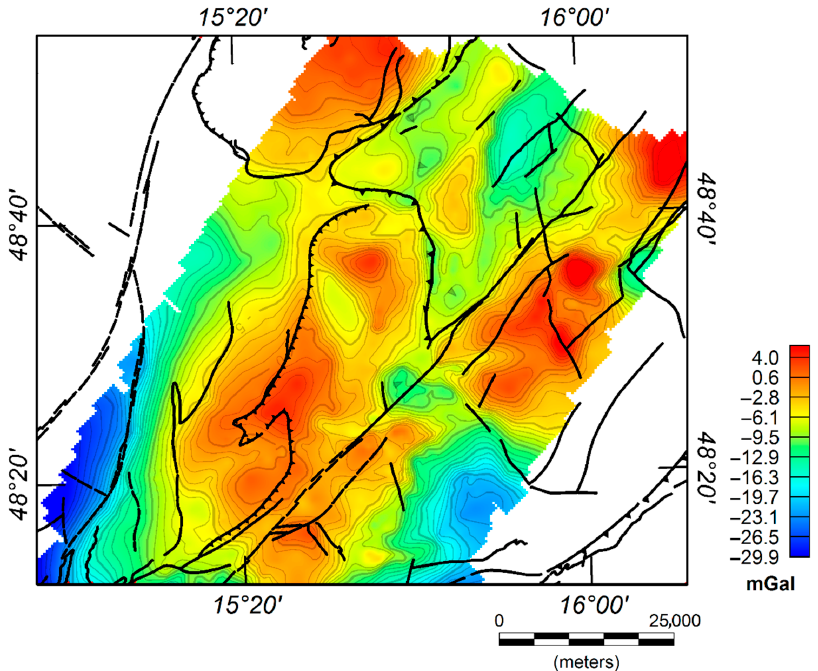
Figure 3. Bouguer map of the study area. The main maxima, with amplitude of about 30 mGal, are located in the central and eastern sections of the map and are often edged by the known faults of the area.